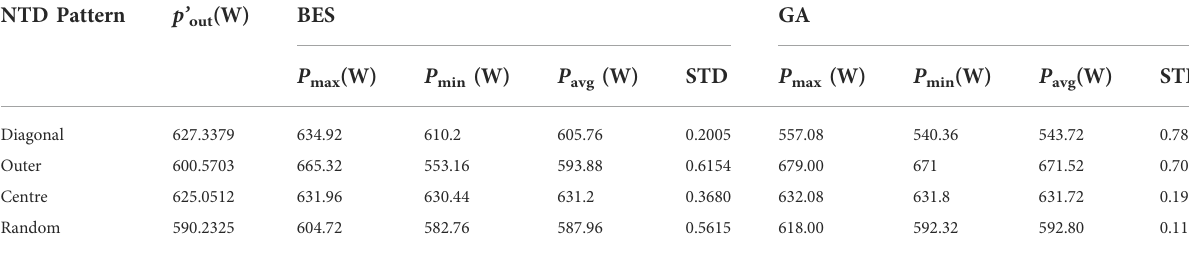
TABLE 1 Output optimal power obtained by BES algorithm under HTD